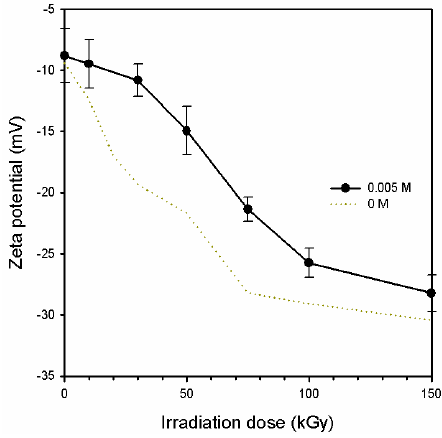
Figure 4. Zeta potential ( ζ -potential) of Ag/PAAc nanogels; PAAc 1 wt%, hexane 3 wt%, 0.005 AgNO 3